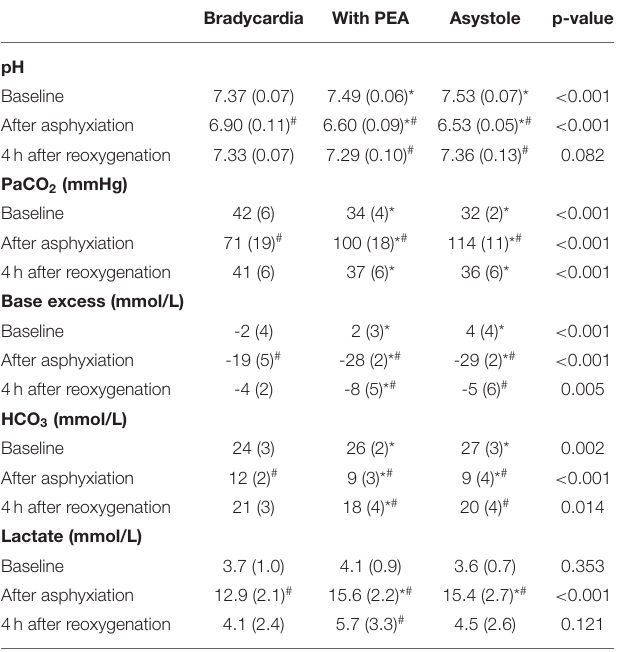
TABLE 4 | Blood gas at baseline, after asphyxiation, and 4h of reoxygenation. Bradycardia With PEA Asystole